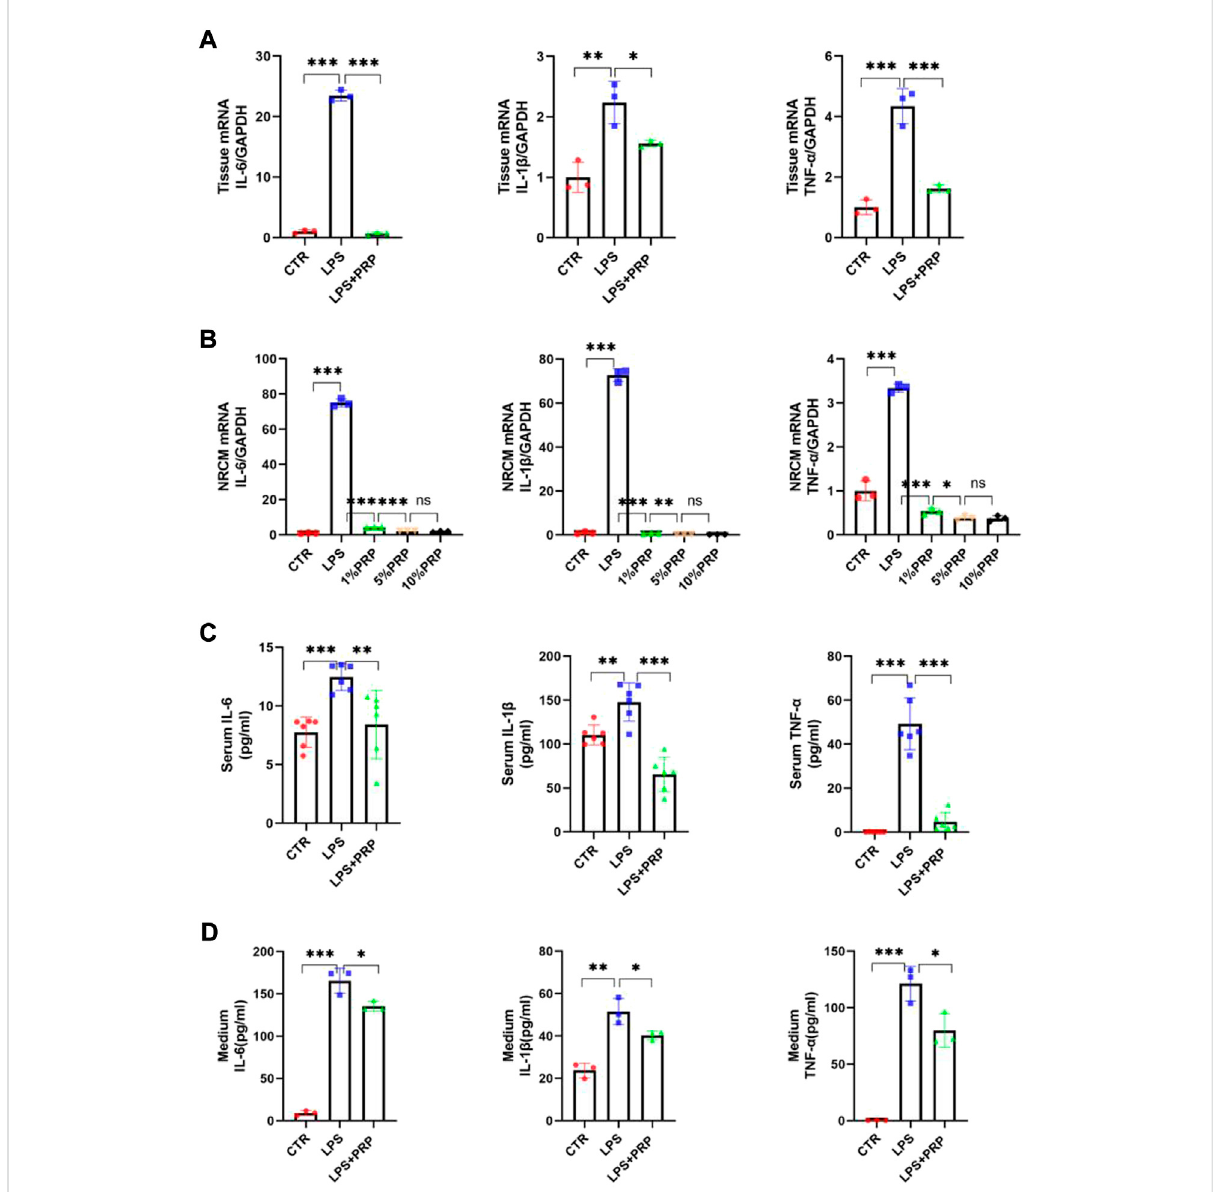
PRP mitigated the in fl ammation caused by LPS. (A) and (B) The mRNA expression levels of IL-6, IL-1 β , and TNF- α in hearts and NRCMs treated withLPSandPRP( n =3). (C,D) ThelevelsofIL-6,IL-1 β ,andTNF- α inserumandcellculturemediumweremeasuredbyELISA( n =6, n